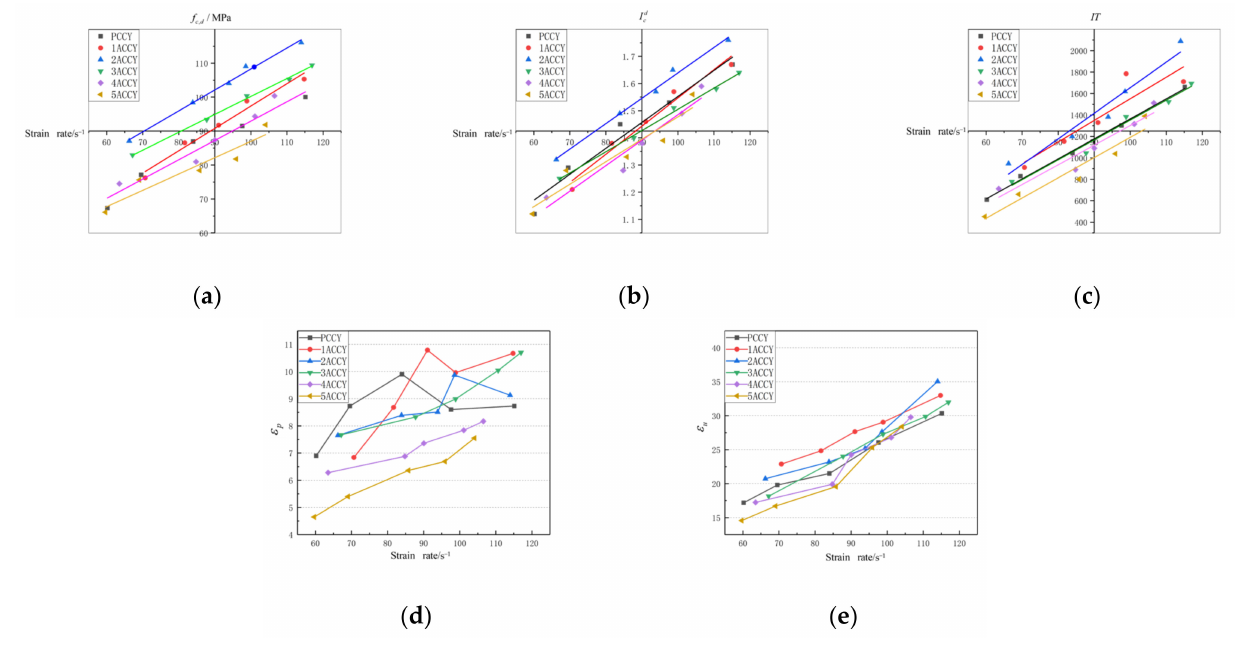
Figure 7. Performance of concrete specimen ( a ) f c , d ; ( b ) I d c ; ( c ) IT ; ( d ) ε p ; ( e ) ε u